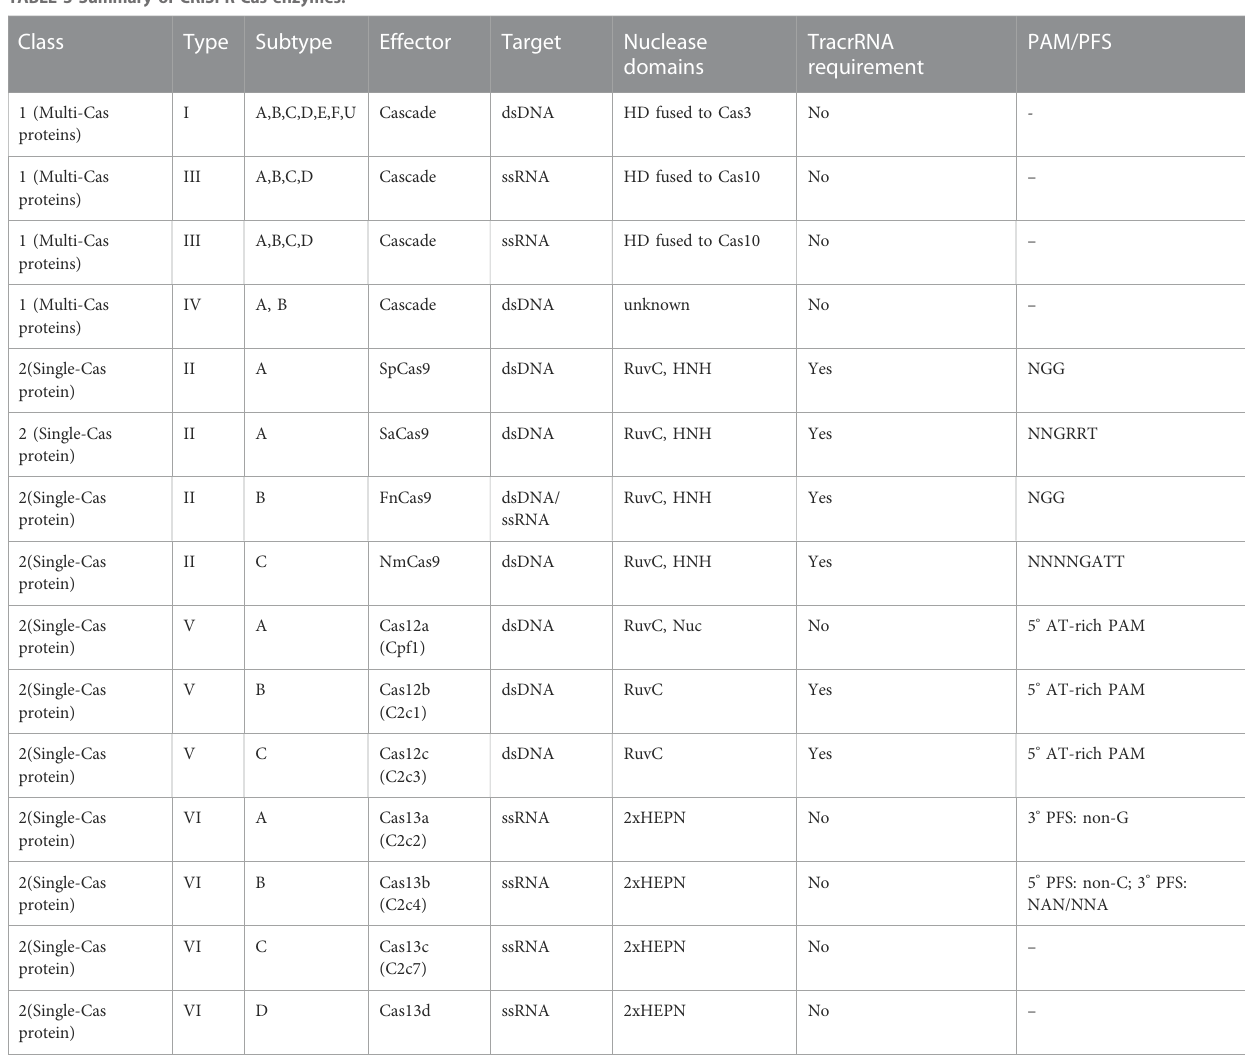
TABLE 3 Summary of CRISPR-Cas